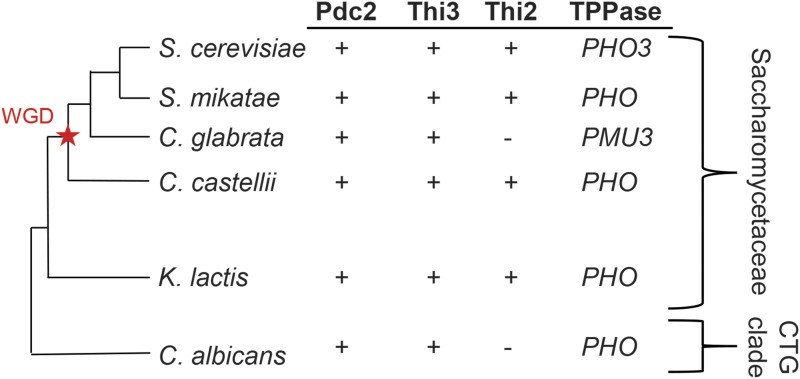
Phylogenetic relationships and presence or absence of thiamine signal transduction pathway transcription factors and thiamine pyrophosphatases (TPPases). Using a phylogeny of yeast (Gabaldón and Carreté 2016; He et al. 2017), presence or absence of genes was determined previously (Wapinski et al. 2007; Huerta-Cepas et al. 2014). C. glabrata lacks THI2 as do the other “glabrata group” yeast (not presented in figure), but only C. glabrata contains the PMU array of genes (Gabaldón Estevan et al. 2013). We believe that the S. cerevisiae THI pathway behaves similar to the ancestral pathway, and C. glabrata has lost Thi2, gained PMU3, and is unable to synthesize thiamine de novo. WGD (and the star) refers to the whole genome duplication event, and CTG clade refers to the altered codon usage of C. albicans.